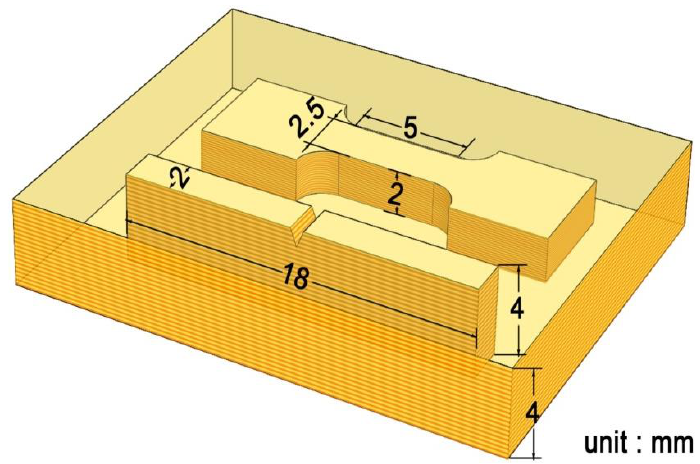
Figure 3. Schematic illustration of the selection of a tension sample and Charpy impact sample.